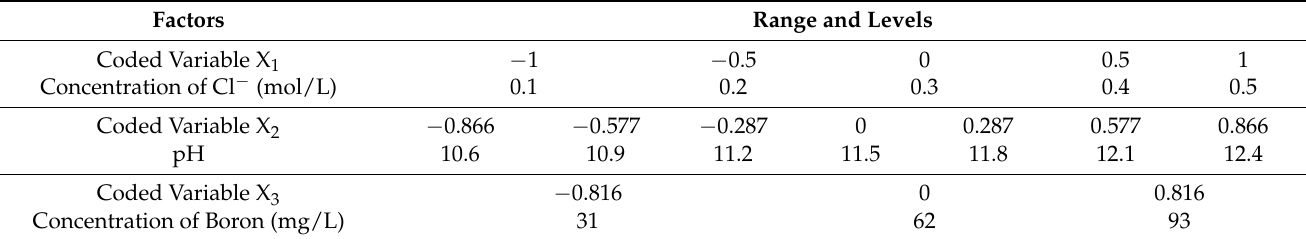
Table 4. Experimental range and levels of the